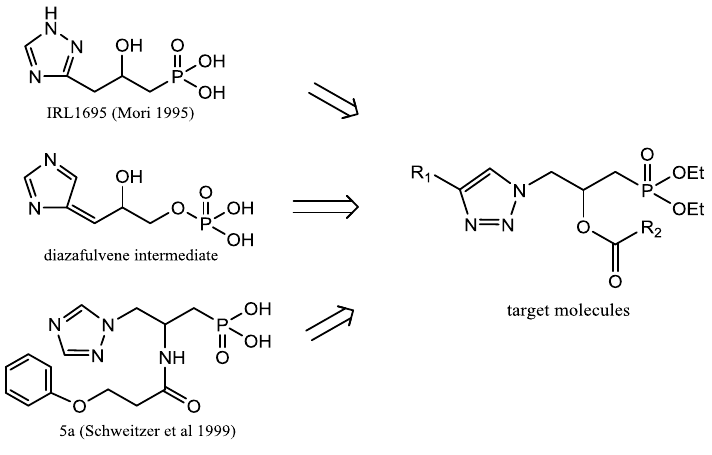
Figure 1. The design of the target molecules.